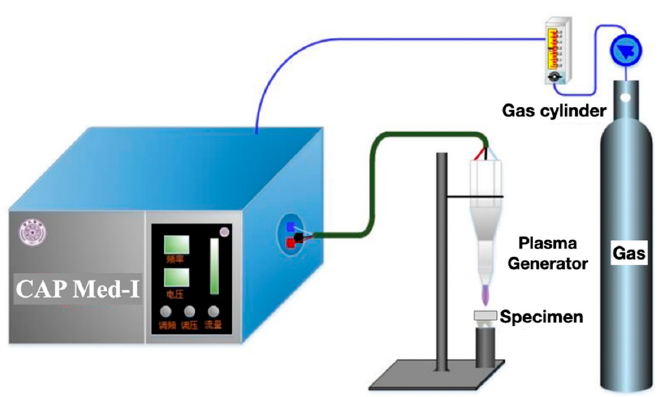
Figure 2. CAP-Med I equipment used in this study for plasma jet generation. After treatment, specimens in all five groups (five specimens per group) were first observed in a scanning electron microscopy (SEM) (S-4800, Hitachi, Japan) at 35 mA for 85 s, after sputter-coated with Au-Pd alloy. The surface roughness of specimen was measured by a stylus surface profilometer (SJ-401, Mitutoyo, Japan), including Ra (arith- metical mean height, in μ m) and Rz (maximum height of surface roughness profile, in μ m). They were both determined with a cut-off value of 0.8 mm, measurement length of 4 mm. For each specimen, three times was measured at different areas and five specimens per group. The wettability of surface to water was determined by a contact angle goniometer (SL200, USA Kino Industry, Norcross, GA, USA). Static contact angle was measured using tangential line method. On each specimen, 1 μ L deionized water droplet was applied with an automatic piston syringe. Three randomly selected points on each specimen were ex- amined, and five specimens per group. Electron spectroscopy for chemical analysis (ESCA) was used to evaluate the compo- sition of the treated surface. It was conducted by X-ray photoelectron spectroscopy (Kra- tos Analytical, Manchester, UK) to evaluate the intensity of carbon, oxygen and silicon on the surface. The binding energy of each spectrum was calibrated with C1s (284.8 eV). 2.3. Shear Bond Strength Test 180 prepared RNC specimens were randomly divided into nine groups according to different surface treatments (Table 2). Table 2. Different surface treatment of nine groups before binding. Groups